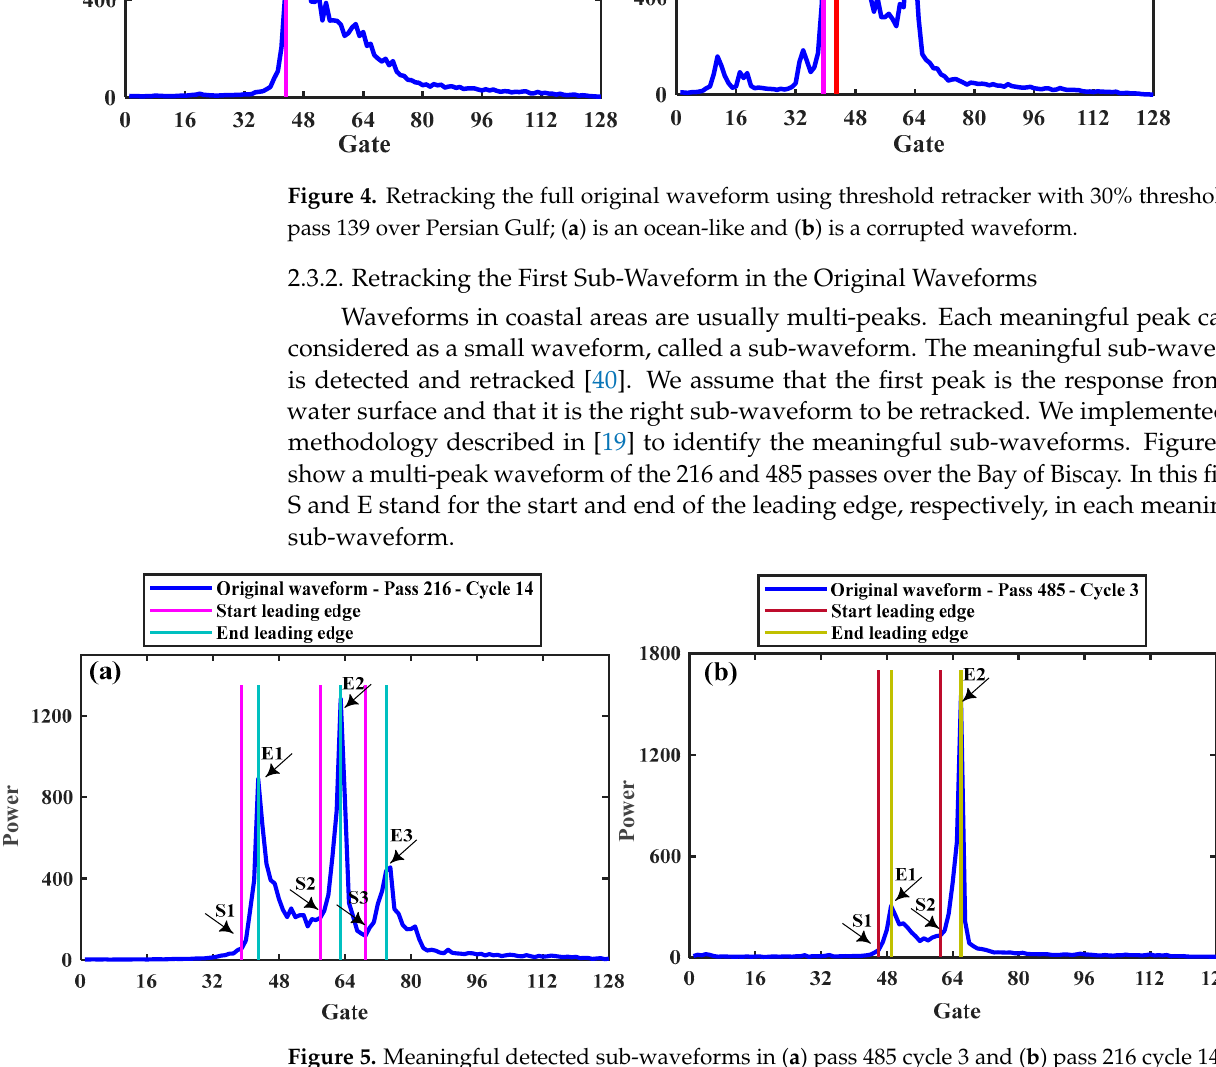
Figure 5. Meaningful detected sub-waveforms in ( a ) pass 485 cycle 3 and ( b ) pass 216 cycle 14 over the Bay of Biscay.